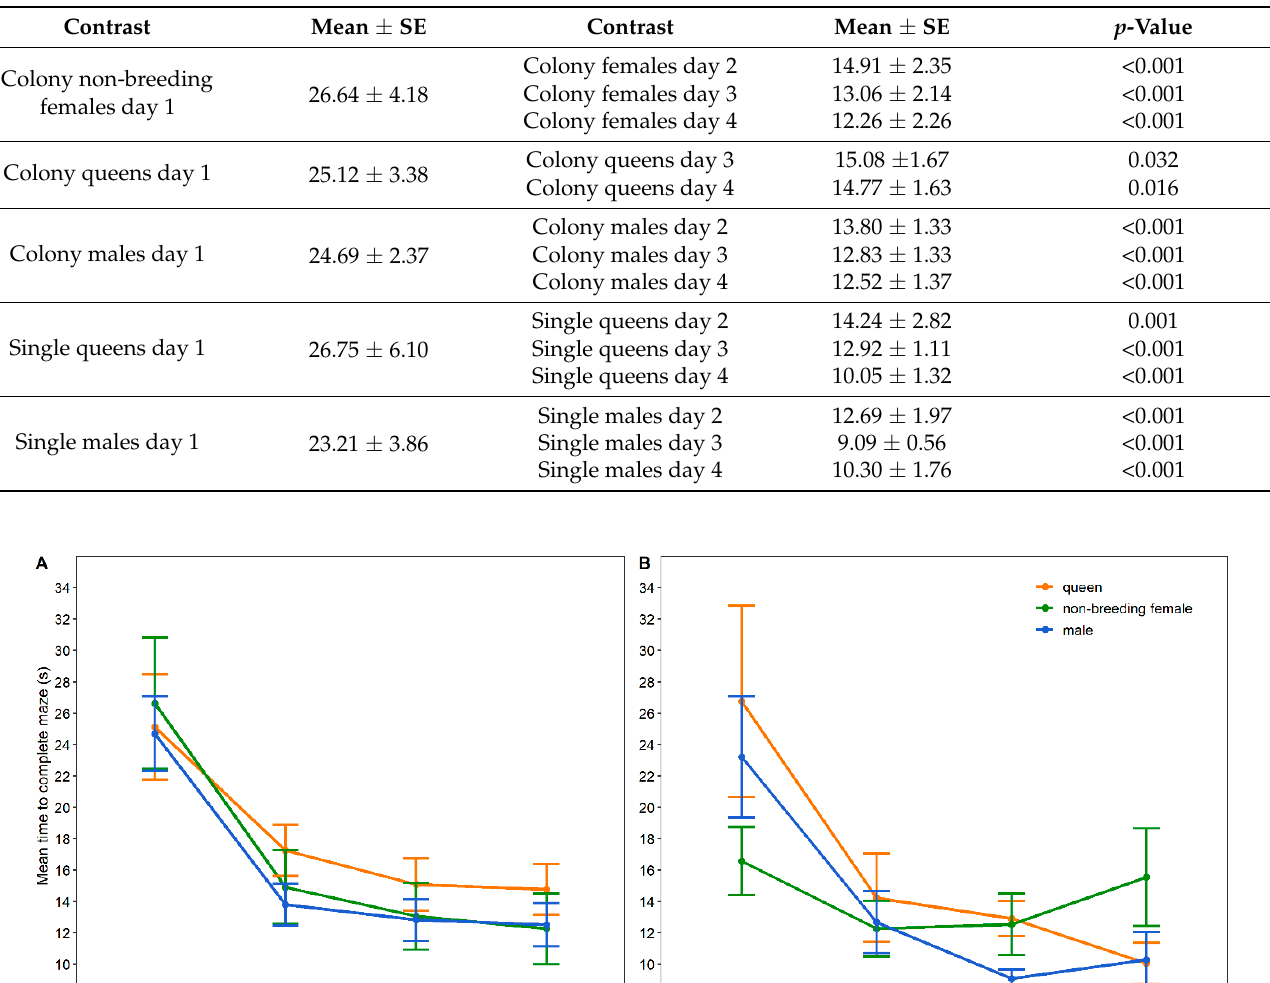
Table 2. Significant post hoc differences in the mean time to complete a Y-shaped maze in Experiment 2 between experimental day 1 and days 2, 3 and 4.